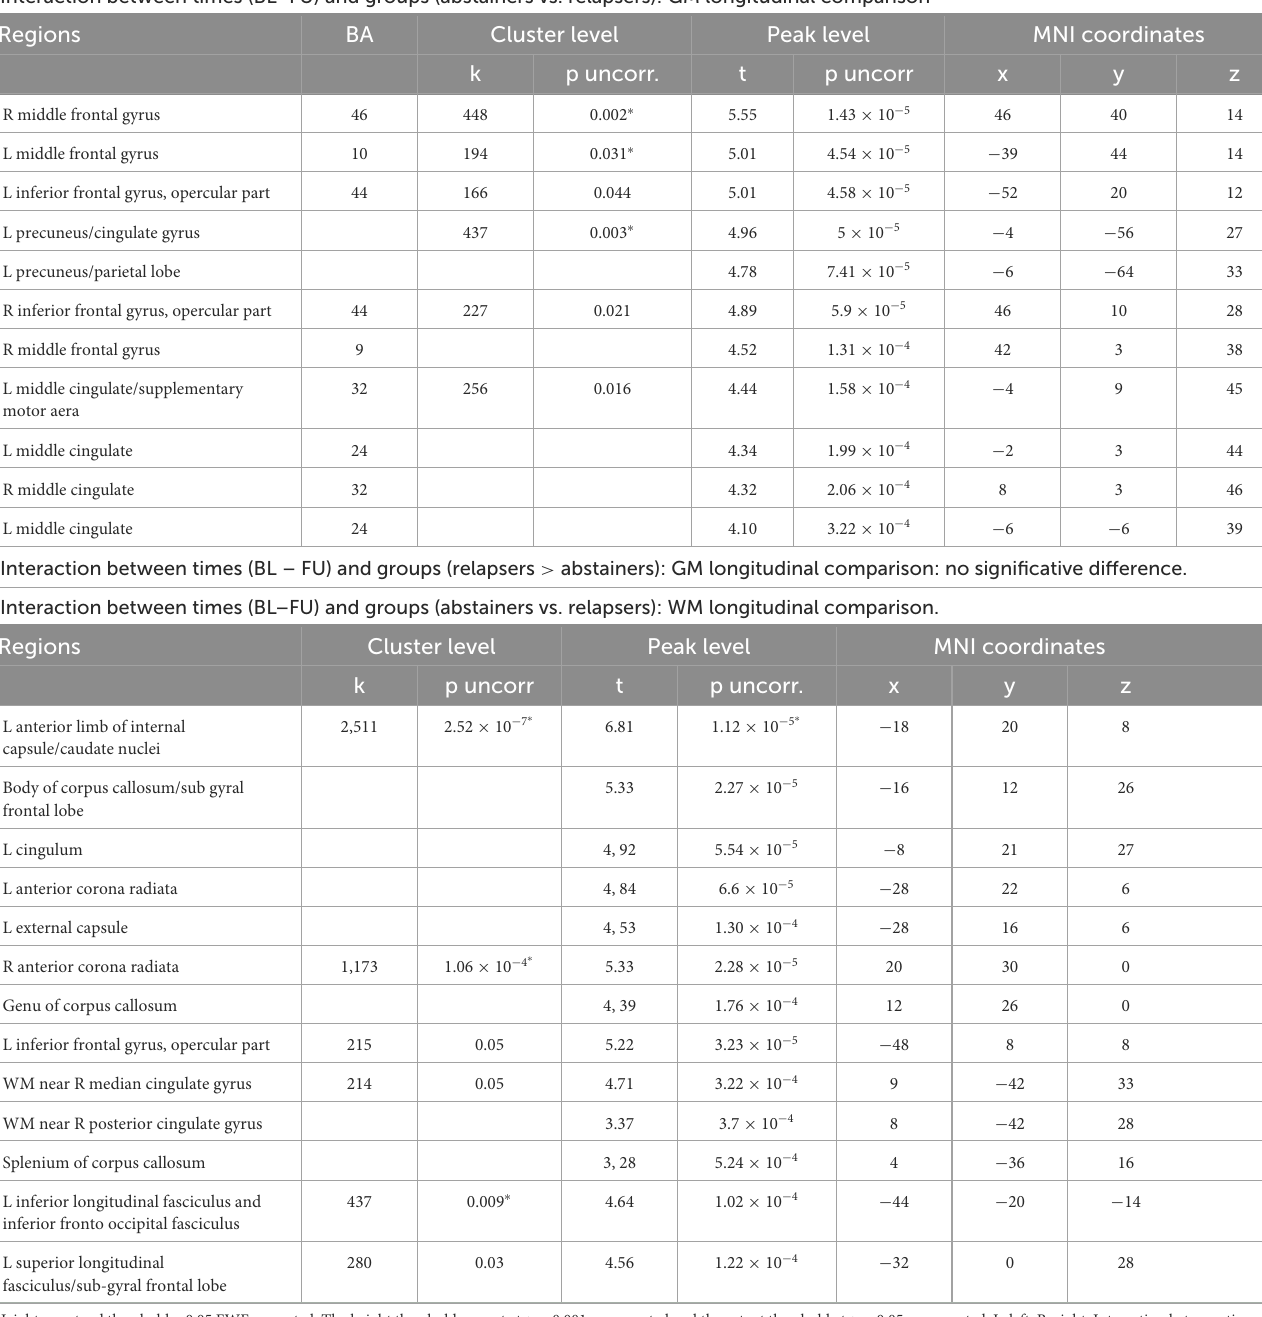
TABLE 3 Grey Matter (GM) and White Matter (WM) longitudinal analyses: comparisons between relapsers and abstainers. Interaction between times (BL–FU) and groups (abstainers vs. relapsers): GM longitudinal comparison Regions BA